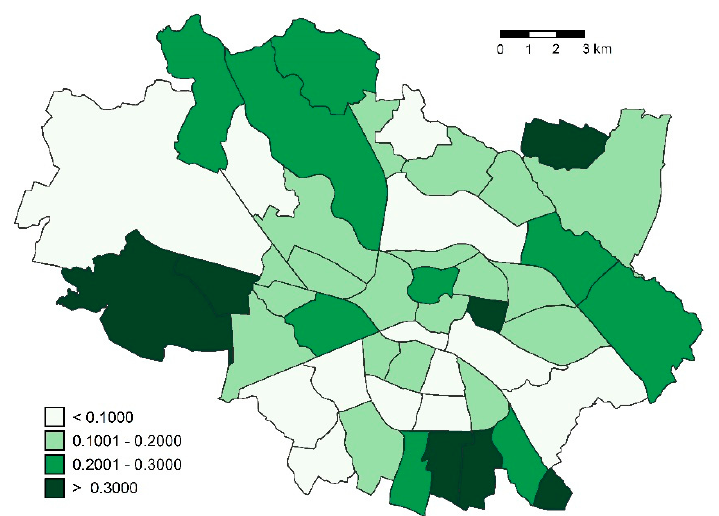
Figure 12. Index of specializations in the housing estate of Wroc ł aw in 2016 (sourced by authors).